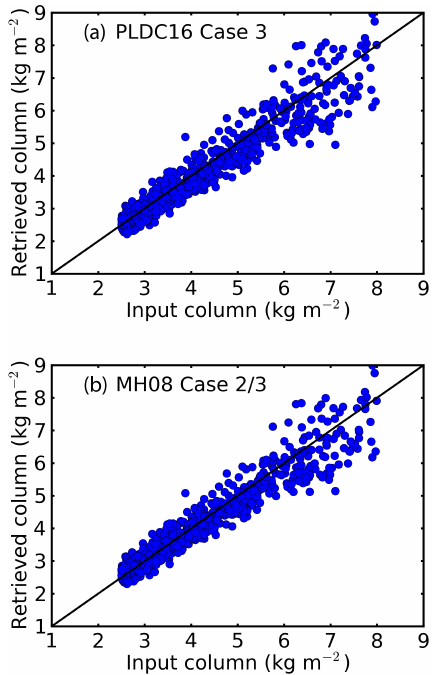
Figure 4. Comparisons of mid regime retrievals (excluding over- lap) from simulated signals against the input water vapour columns for (a) PLDC16 and (b) MH08. The simulated brightness temper- atures include Gaussian noise with a 0 . 5K standard deviation, and perfect auxiliary information is provided. The black line represents a perfect retrieval.